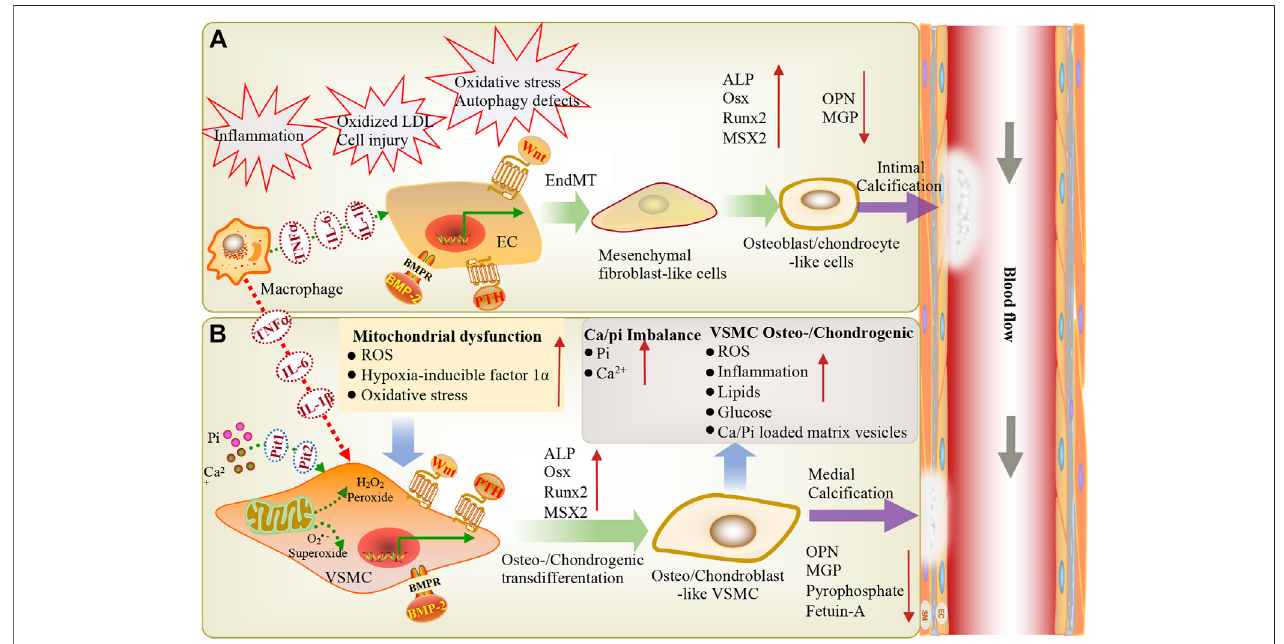
FIGURE 1 | During in fl ammation, macrophages in fi ltrate through EC adhesion and migration across endothelial cells, resulting in macrophage activation and the releaseofin fl ammatorycytokines(TNF- α ,IL-6,IL-1 β ),furtherstimulatingVSMCsandECs,eventuallyleadingtovascularcalci fi cation. Vascularendothelialcellsexposed to shear stress induced by blood fl ow are more sensitive to shear stress-induced EndMT and BMP-induced osteogenic differentiation, thereby triggering endothelial damage and inducing vascular calci fi cation. (A) Endothelial cells can be stimulated via in fl ammation, oxidative LDL aggregation, cell injury, oxidative stress, and autophagy defects. BMP, PTH and Wnt signaling are involved in endothelial mesenchymal transformation, the differentiation of endothelial cells into mesenchymal fi broblasts, and their further differentiation into osteoblast-like cells. These changes are accompanied by a high expression of osteogenic genes (ALP, Runx2, BMP2, MSX2) and lowexpression ofthecalci fi cation inhibitor MGP, leadingtointimalcalci fi cation. (B) Ca 2+ /P i imbalanceand mitochondrial dysfunctionlead toreactive oxygen species production and oxidative stress. BMP, Wnt, and PTH signaling induce the osteogenic/chondrogenic differentiation of vascular smooth muscle cells, ultimately leading to medial calci fi cation. EC: endothelial cells; VSMC: vascular smooth muscle cell; ALP: alkaline phosphatase; Pit1, Pit2: NaPi cotransporters; LDL: low-density lipoprotein; OPN: osteopontin; PTH: parathyroid hormone; Runx2: runt-related transcription factor-2; Msx2: msh homeobox-2; IL1- β : interleukin-1 beta; IL-6: interleukin-6; Osx: osterix; EndMT: endothelial-mesenchymal transition; BMP: Bone morphogenetic protein; ROS: Reactive oxygen species; TNF- α : tumor necrosis alpha; Pi: inorganic